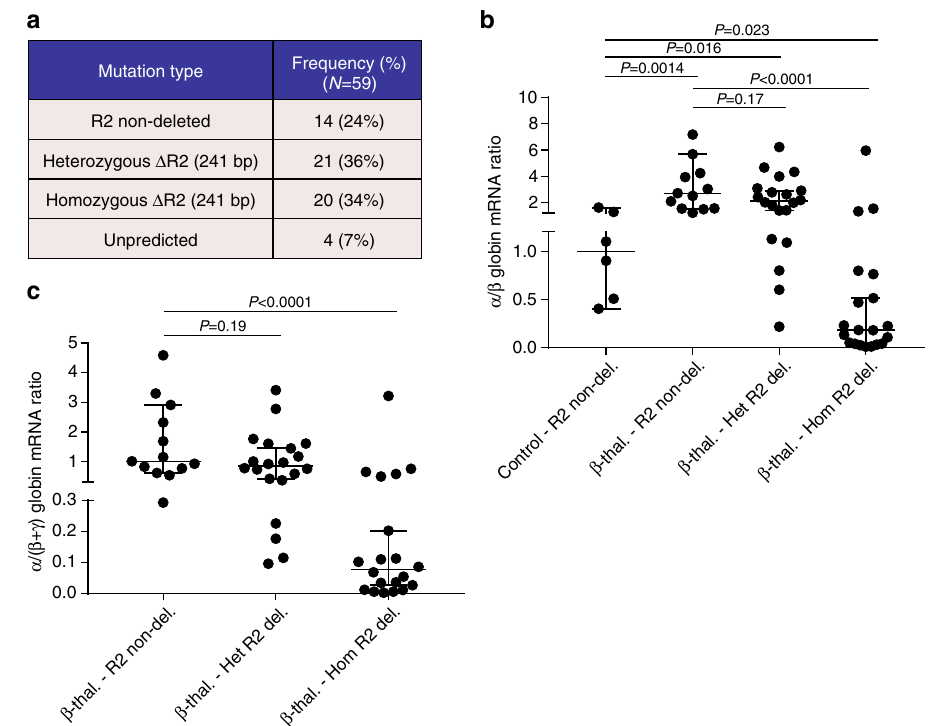
Fig. 5 Deletion of MCS-R2 in CD34+ cells from HbE β -thalassemia patients using Cr2 + Cr12. a Frequency of different types of mutations generated. b α / β -globin mRNA ratios of individual clones of erythroid cells which are non-deleted normal control ( n = 6), non-deleted HbE β -thalassemia ( n = 13), HbE β -thalassemia heterozygous for the deletion of MCS-R2 ( n = 20), and HbE β -thalassemia homozygous for the deletion of MCS-R2 ( n = 20) analyzed by qPCR; median ( horizontal bar ) and 95% con fi dence interval ( error bar ) are shown and P -values were calculated using Mann – Whitney U -test. c Data for α /( β + γ ) globin mRNA ratios for individual clones of HbE β -thalassemia erythroid cells grouped according to genotype and normalized to median of non-deleted HbE β -thalassemia clones; median ( horizontal bar ) and 95% con fi dence interval ( error bar ) are shown and P -values were